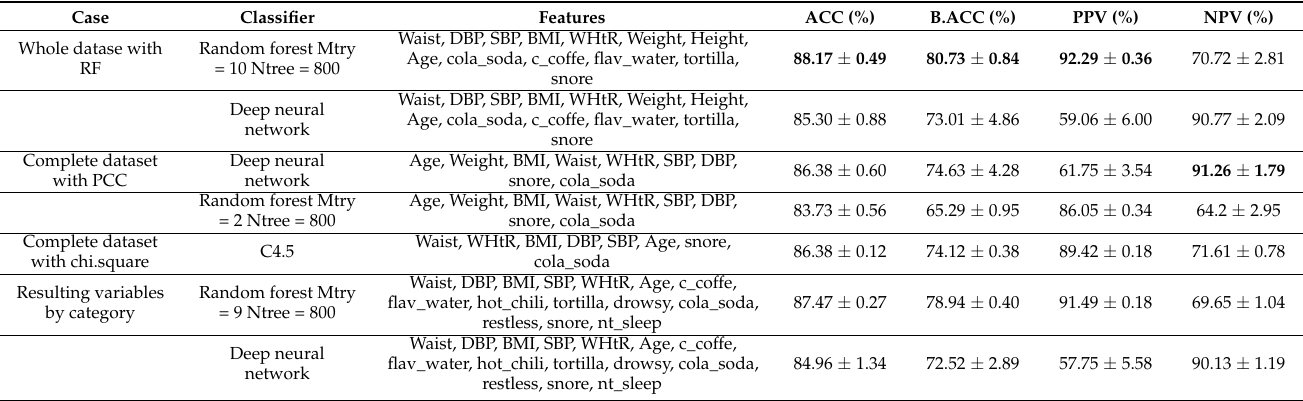
Table 5. Model performance in